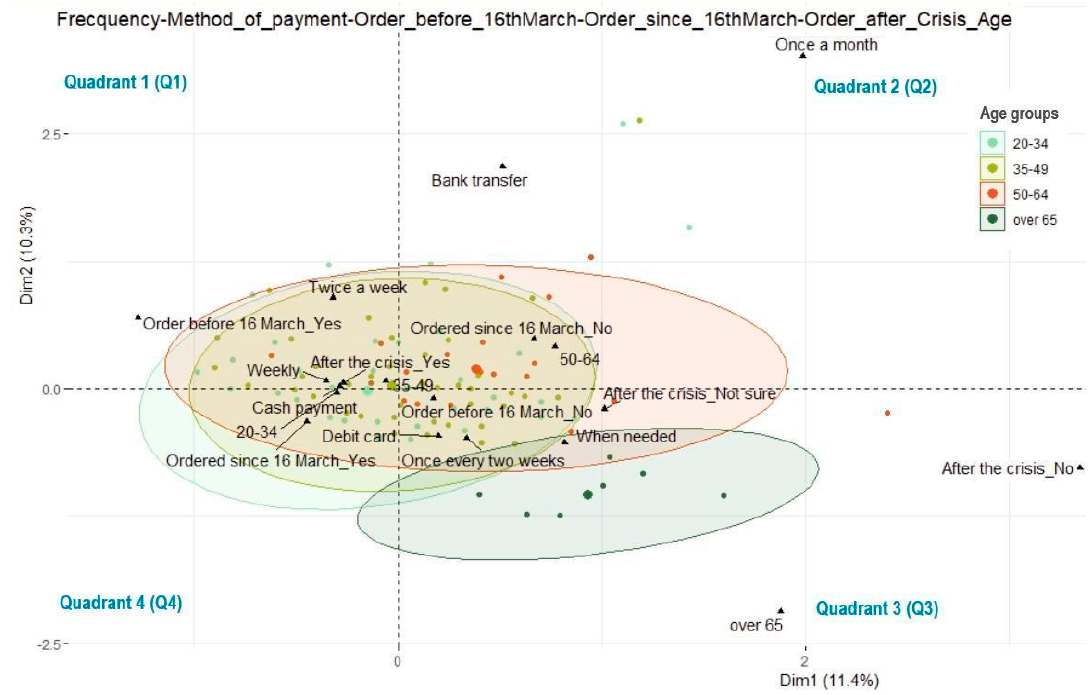
Figure 14. Biplot with multivariate correspondence depending on frequency, age groups, method of payment, and purchase decision of fresh vegetables directly from producers before and after March 16 and post COVID-19 crisis.